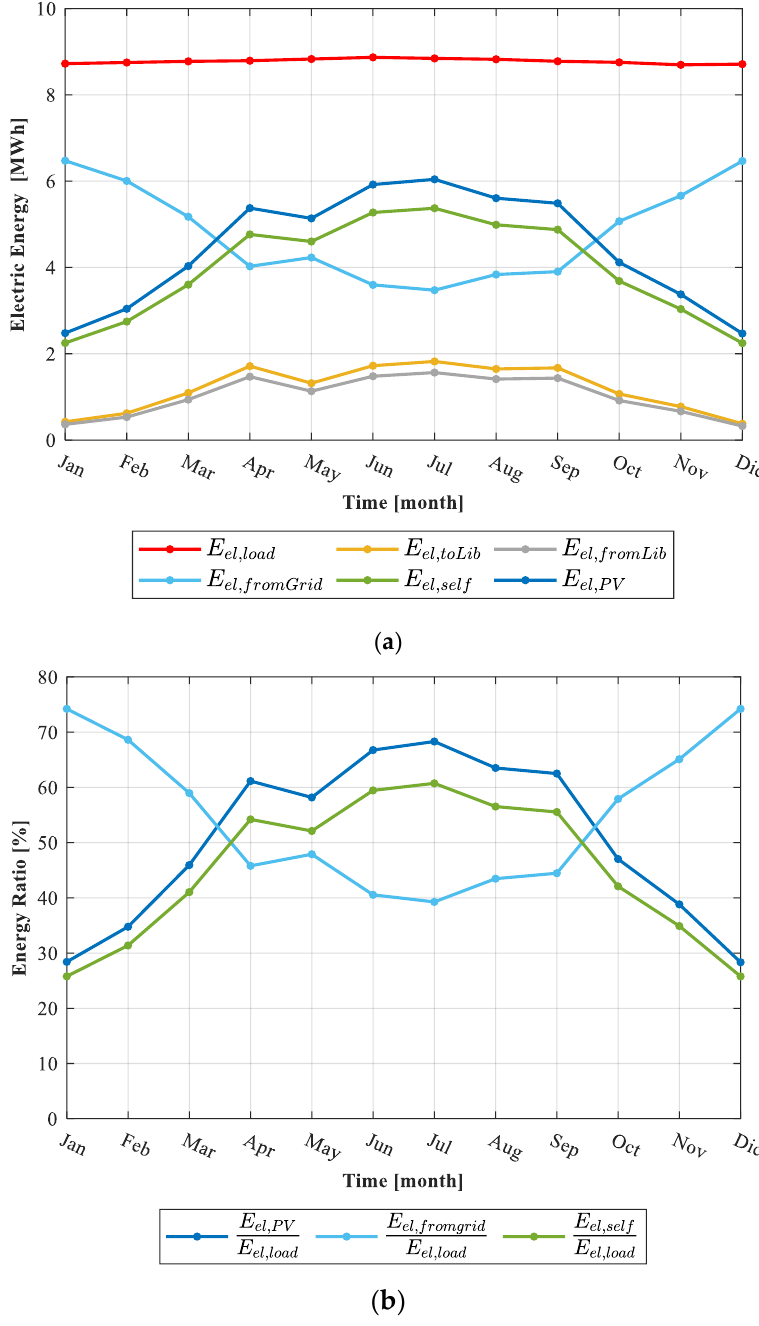
Figure 6. Results for monthly electric energies. Figure 6. Monthly results for electric energies ( a ) and electric energy ratios ( b